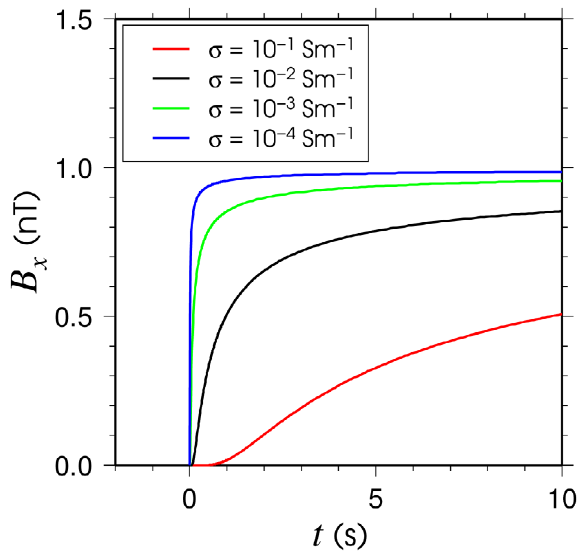
Figure 5. A comparison of the temporal variation in the horizontal component of the magnetic field for the source-receiver geometry shown in Figure 4a for four conductivity